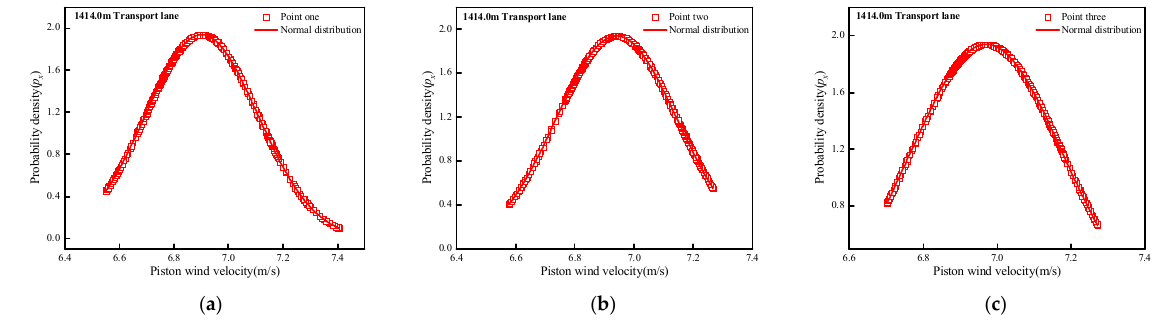
Figure 15. Probability density of characteristic points of 1584.0 m transport lane: ( a ) Point one, ( b ) Point two, ( c ) Point three.